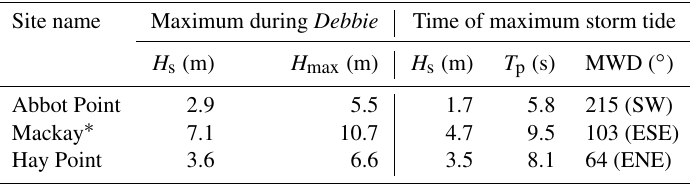
Table 3. Wave conditions observed (north to south) during Debbie . Both maximum wave heights and wave conditions at the time of maximum storm tide are shown.